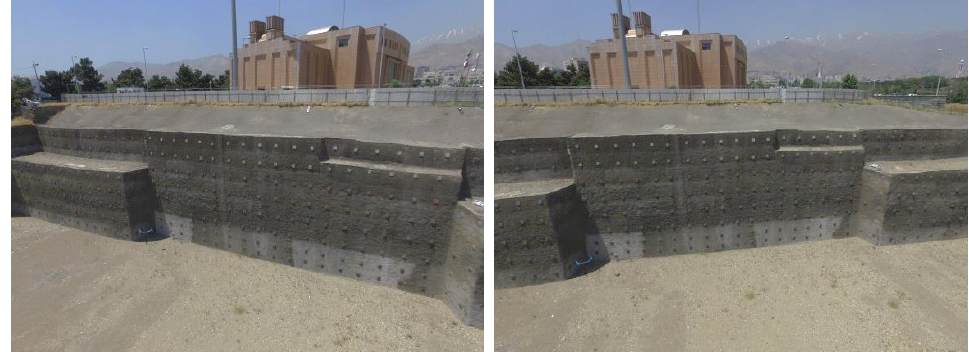
Figure 13. Sample observations captured using the Phantom 3 Pro for displacement monitoring of the excavated wall.